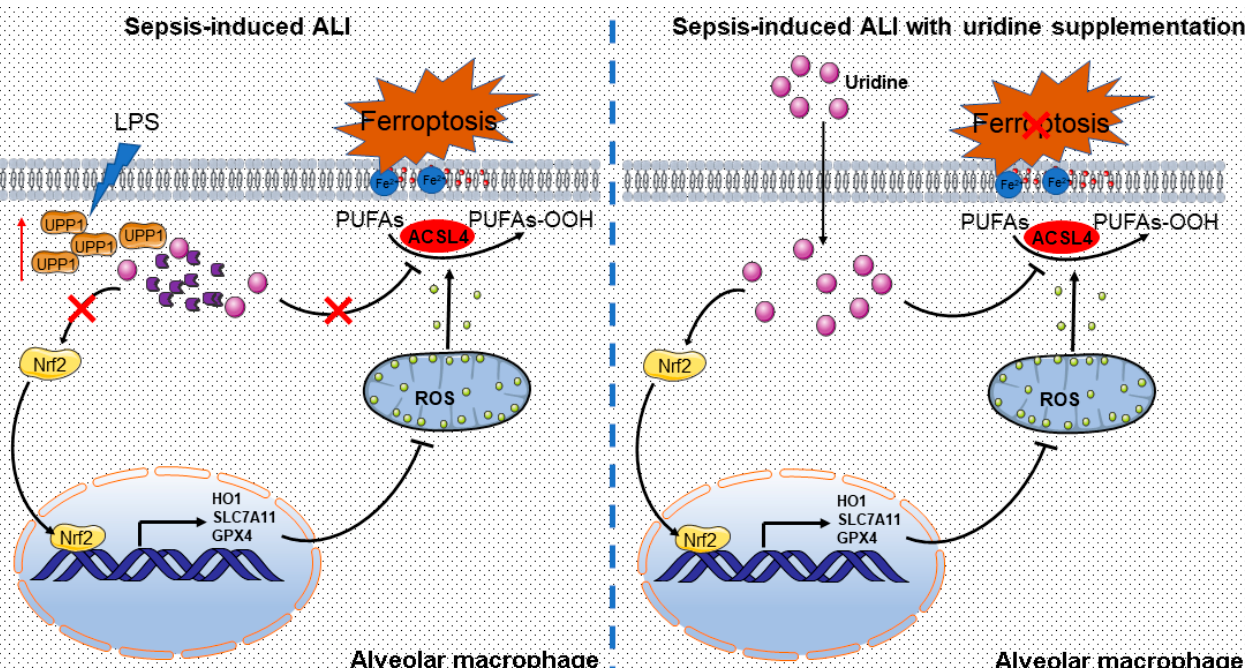
Figure 8. Graphical abstract for uridine supplementation alleviates sepsis-induced ALI. The possible mechanisms by which uridine imposes antioxidative effects to protect against ferroptosis in sepsis- induced ALI.